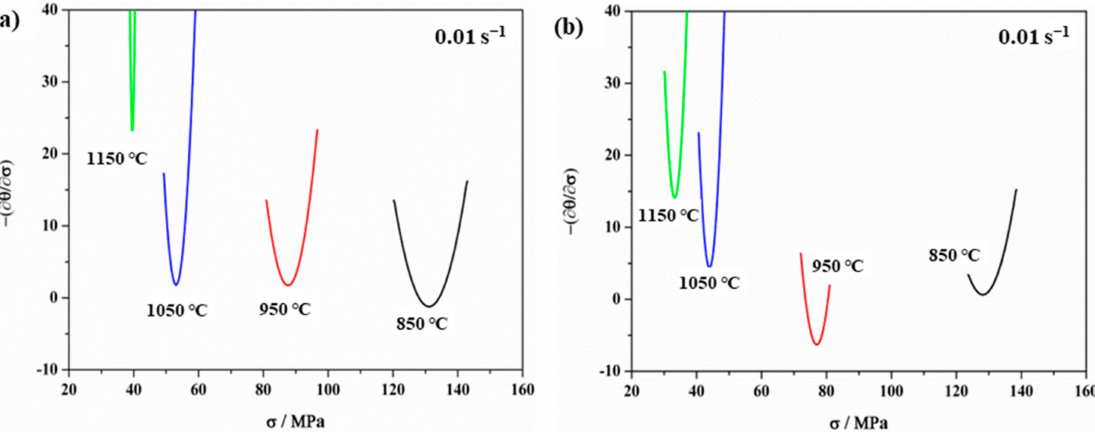
Figure 7. Relationship between − ∂σ / ∂ε and σ of 35CrMo steel at 0.01 s − 1 with different deformation temperatures: ( a ) without ultrasonic, ( b ) with